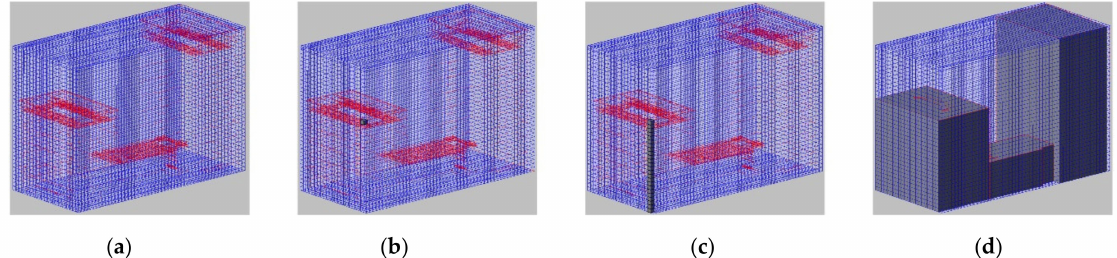
Figure 6. Marking of 3D grids (the 3D grid is projected into the xoz plane to display the result): ( a ) Three-dimensional grid being filled with building point clouds; ( b ) searching grid with point clouds from the top with zero rows and zero columns and then marking it; ( c ) marking all grids below the marked grid layer as true; ( d ) marking all grids according to ( b , c